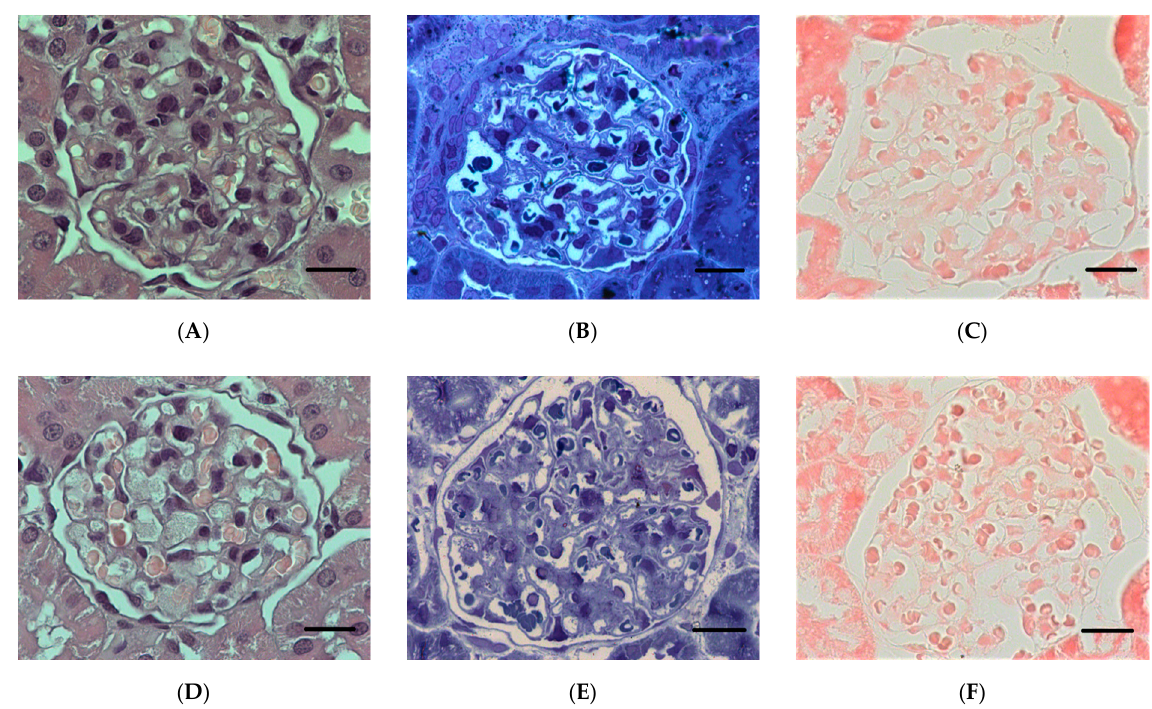
Figure 8. Renal cortex of rat kidney. ( A – C )—control; ( D – F )—24 h after exposure to POX (LD84). H&E stain ( A , D ); methylene blue stain ( B , E ); IHC to nephrin, fast red chromogen ( C , F ). (×1000). Scale bar = 10 µm.